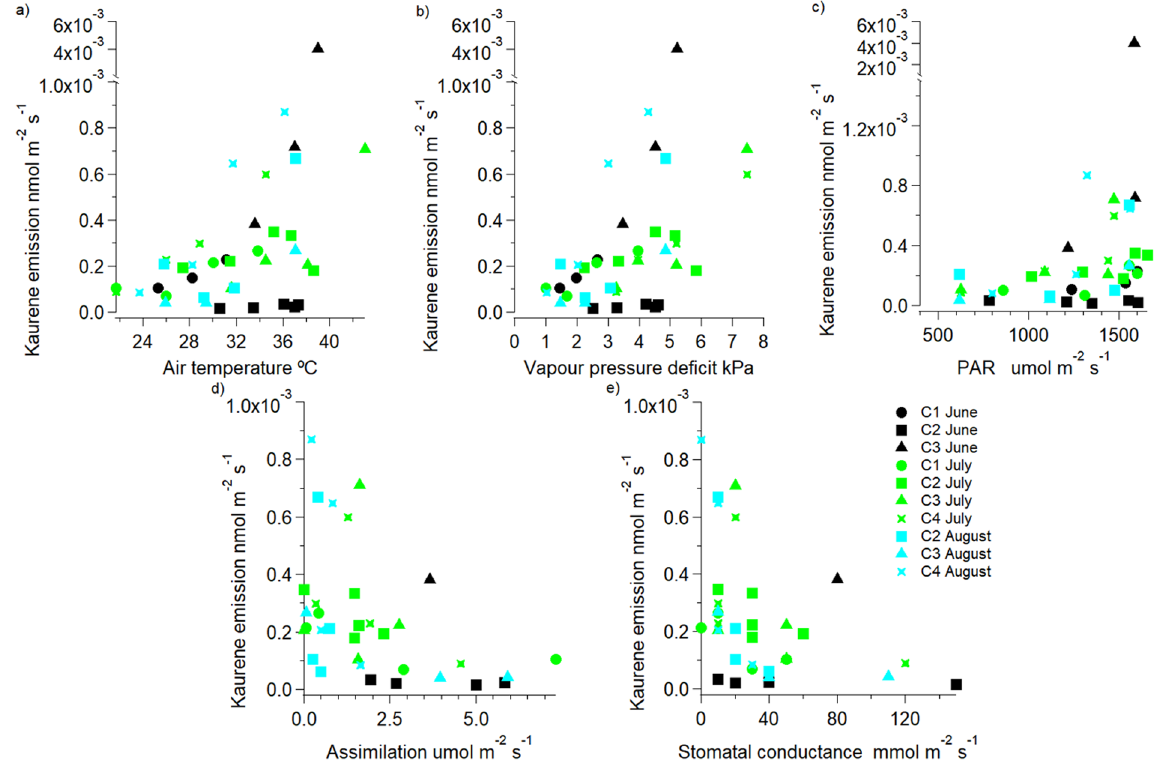
Figure 5. Kaurene emission rates by C . ladanifer under natural conditions plotted against air temperature ( a ) vapour pressure deficit ( b ) photosynthetically active radiation (PAR, ( c ) CO 2 assimilation ( d ) and stomatal conductance ( e ) for four C . ladanifer plants (C1–C4) analysed in the field during June (black), July (green) and August (blue)